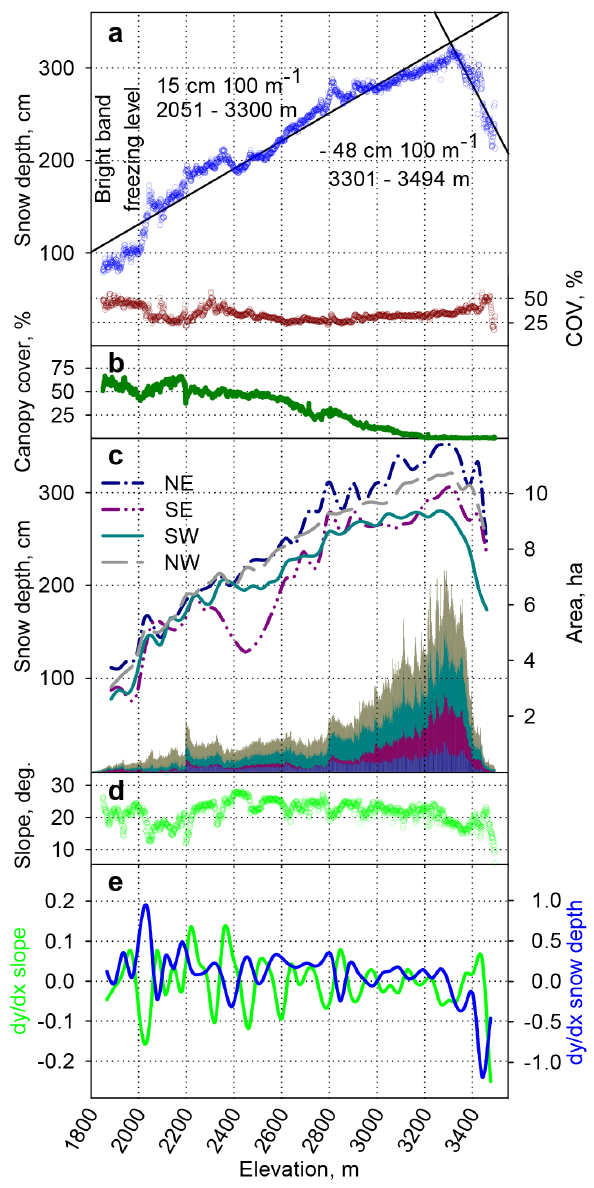
Figure 2. (a) Snow depth (blue) with regression lines and approxi- mate 3 December–23 March bright-band radar freezing level noted, and snow depth percent coefficient of variation (dark red); (b) per- cent canopy cover; (c) 35m running average of mean snow depth and stacked area by elevation for each 90 ◦ quadrant of aspect; (d) mean slope of 1m elevation band; and (e) first derivative of mean slope (green) and snow depth (blue) over 35m running average.